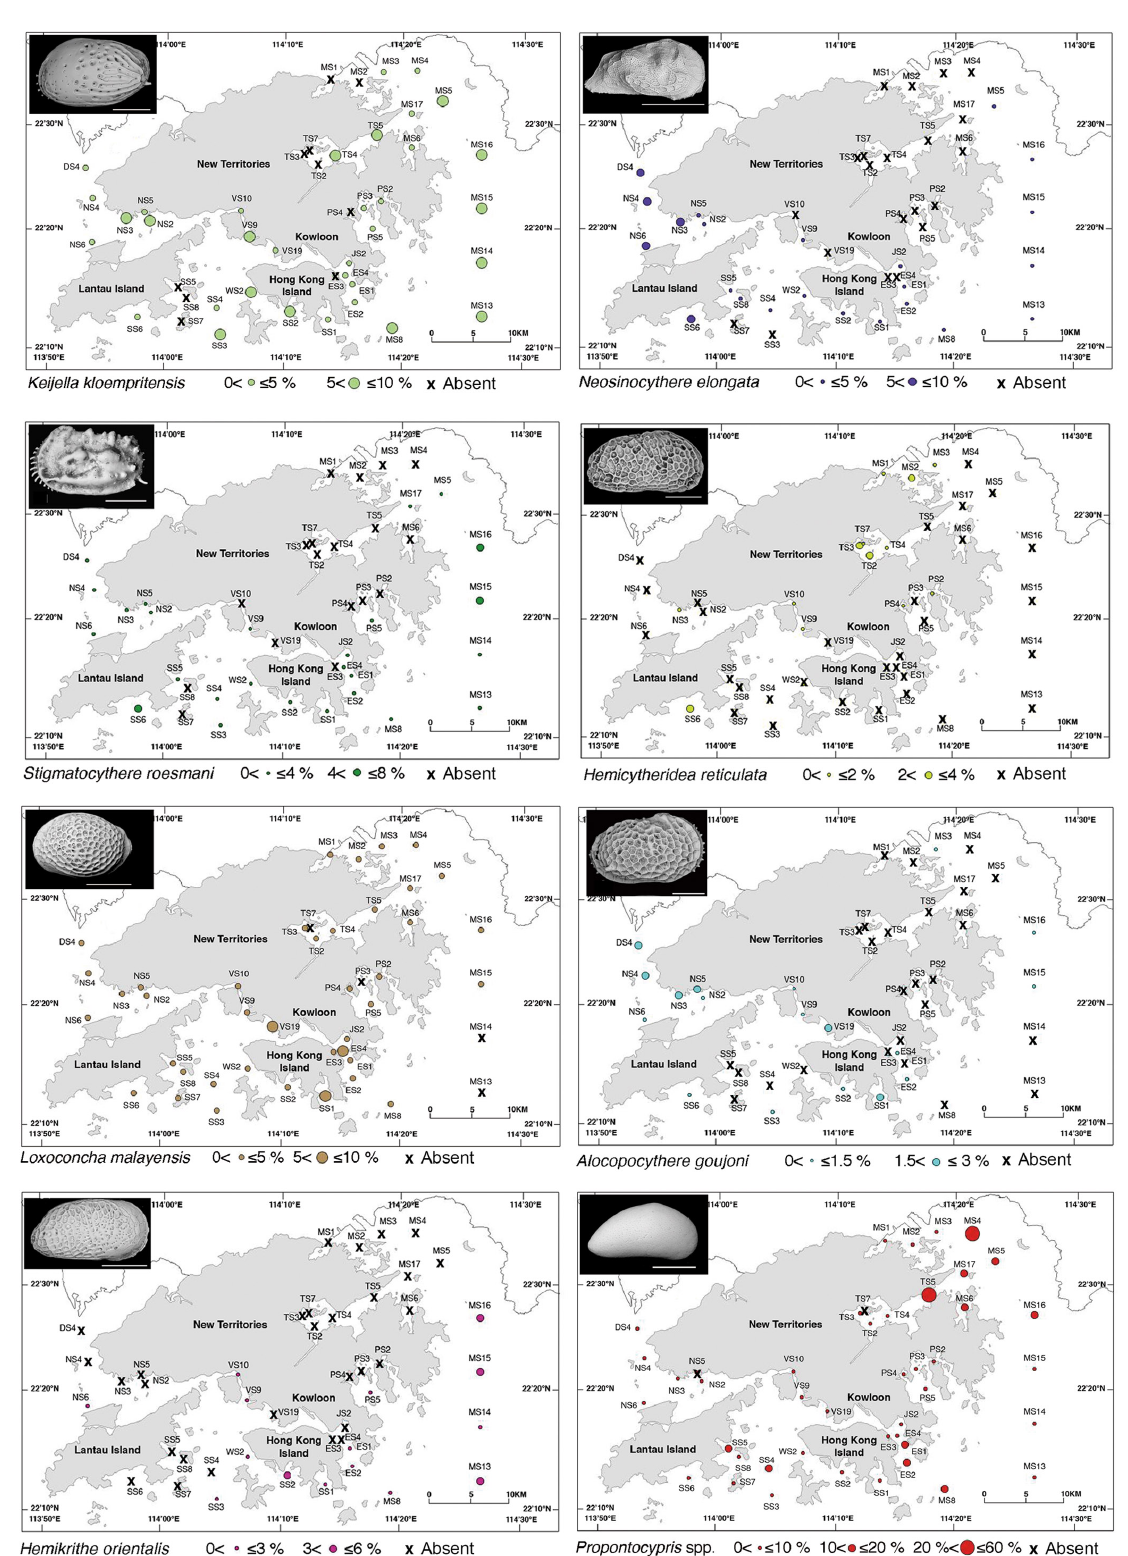
Figure 6. Spatial distribution of the relative abundance for Keijella kloempritensis , Neosinocythere elongata , Stigmatocythere roesmani , Hemicytheridea reticulata Loxoconcha malayensis , Alocopocythere goujoni , Hemikrithe orientalis , and Propontocypris spp. in Hong Kong. The scale bar is